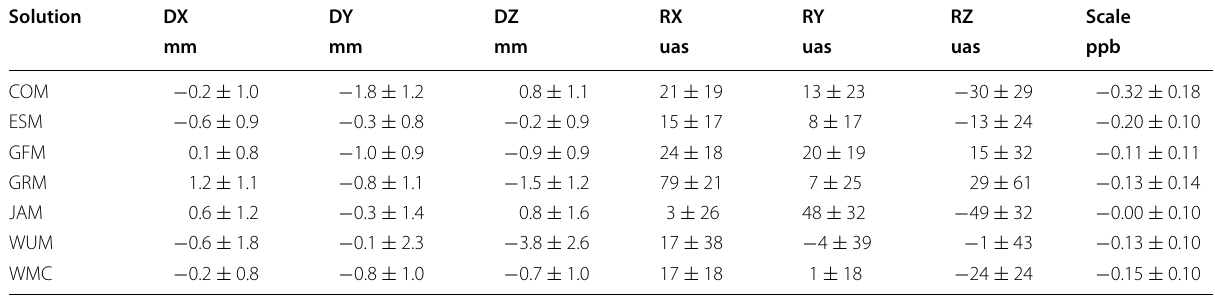
Table 5 Statistics of the transformation parameters for multi-GNSS integrated PPP with respect to IGS daily coordinates. ‘WMC’ indicates a PPP solution using the combined orbit and clock Solution